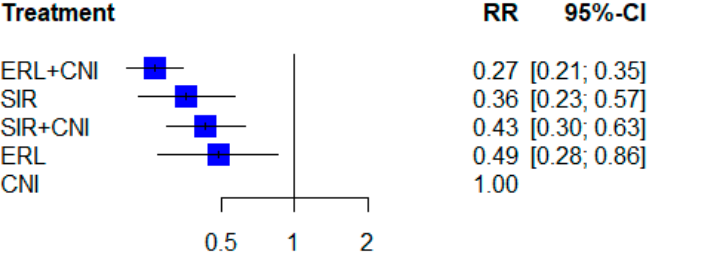
Figure 3. Forest plot indicating the relative risks (RR) of the occurrence of CMV infections on the four different mTOR-Is vs. CNI treatment post transplantation.